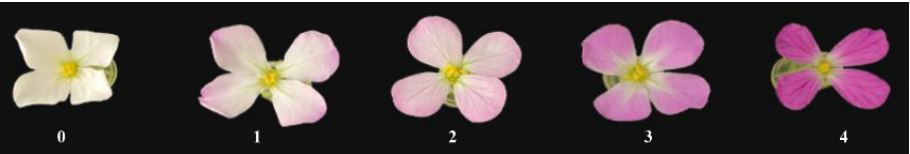
Figure 1. Flower color phenotypes of R. sativus . Flowers are arranged from left to right according to their petal color, which was characterized using the following 0–4 scale: 0, white petals; 1, little purple color from the edge covering <50% of total petals; 2, pink color on edge covering >50% of total petals; 3, pale purple color covering all of the petals; 4, dark purple petals.